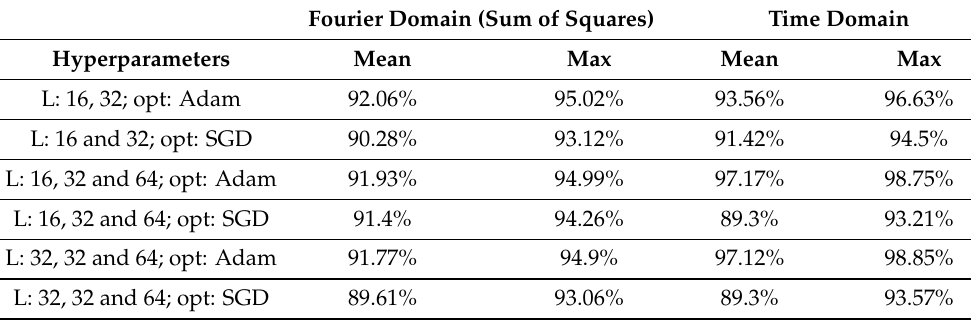
Table 3. The table contains the results of different hyperparameters both in the time and Fourier domains (without inverse FFT) on the HADB dataset. L denotes the number of channels in the consecutive layers from the first to last layer; opt denotes the optimizer, which could be either Adam or Stochastic Gradient Descent (SGD). Fourier Domain (Sum of Squares) Time Domain